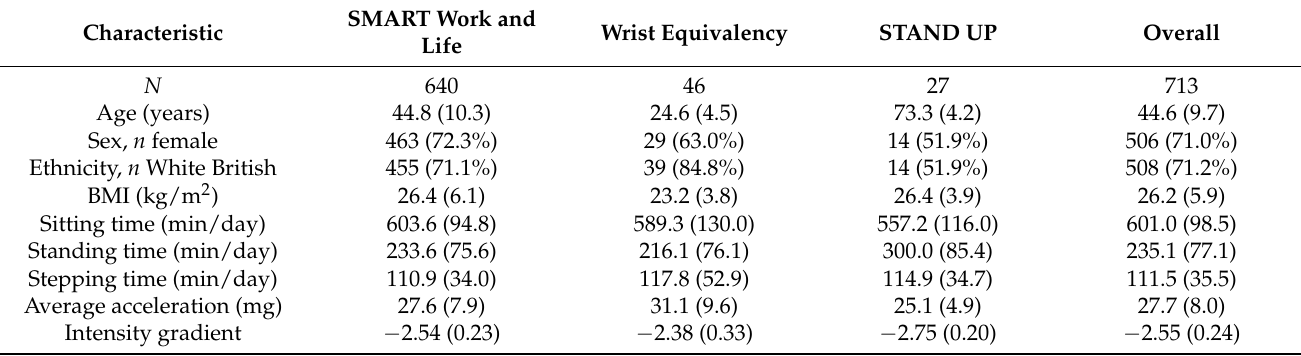
Table 2. Participant characteristics for each